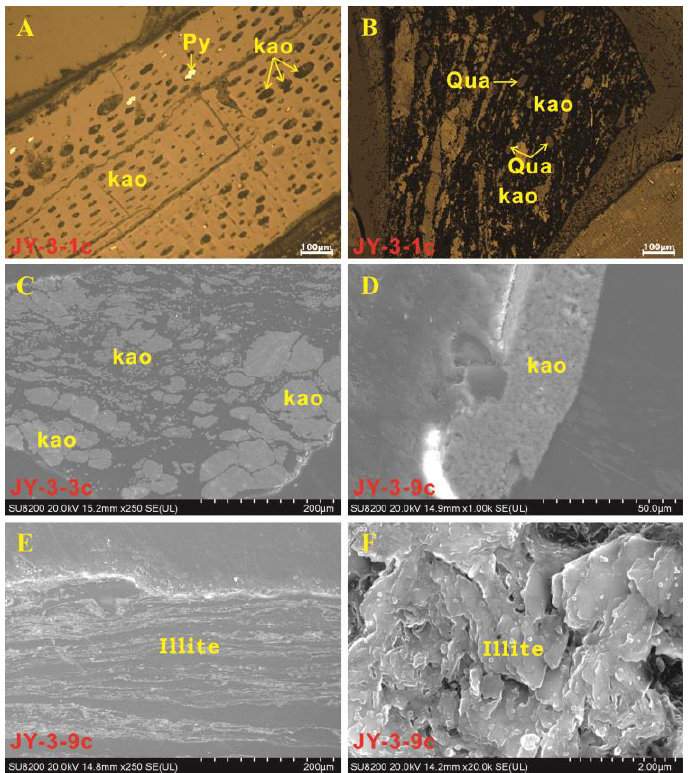
Figure 4. Reflected light optical microscope and SEM secondary electronic images of minerals in the Jinyuan Coal. ( A ), cell-filling kaolinite (Kao) and Pyrite (Py); ( B ), kaolinite distributed along bedding planes; ( C ), kaolinite occurring as pelletoidal fine particles; ( D ), fracture-filling kaolinite; ( E , F ), Illite distributed along bedding planes. Minerals 2020 , 10 , x FOR PEER REVIEW